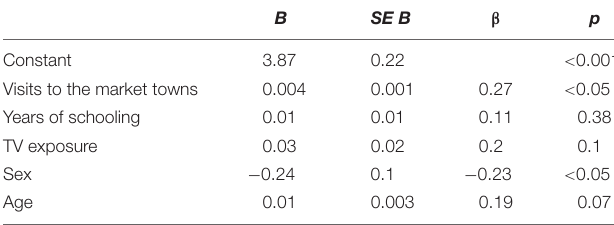
R 2 = 0.22, adjusted R 2 = 0.18, SE = 0.48]. The results of further TABLE 3 | Results of the multiple regression with indicators of modernization, sex and age as predictors and connectedness to nature as the dependent